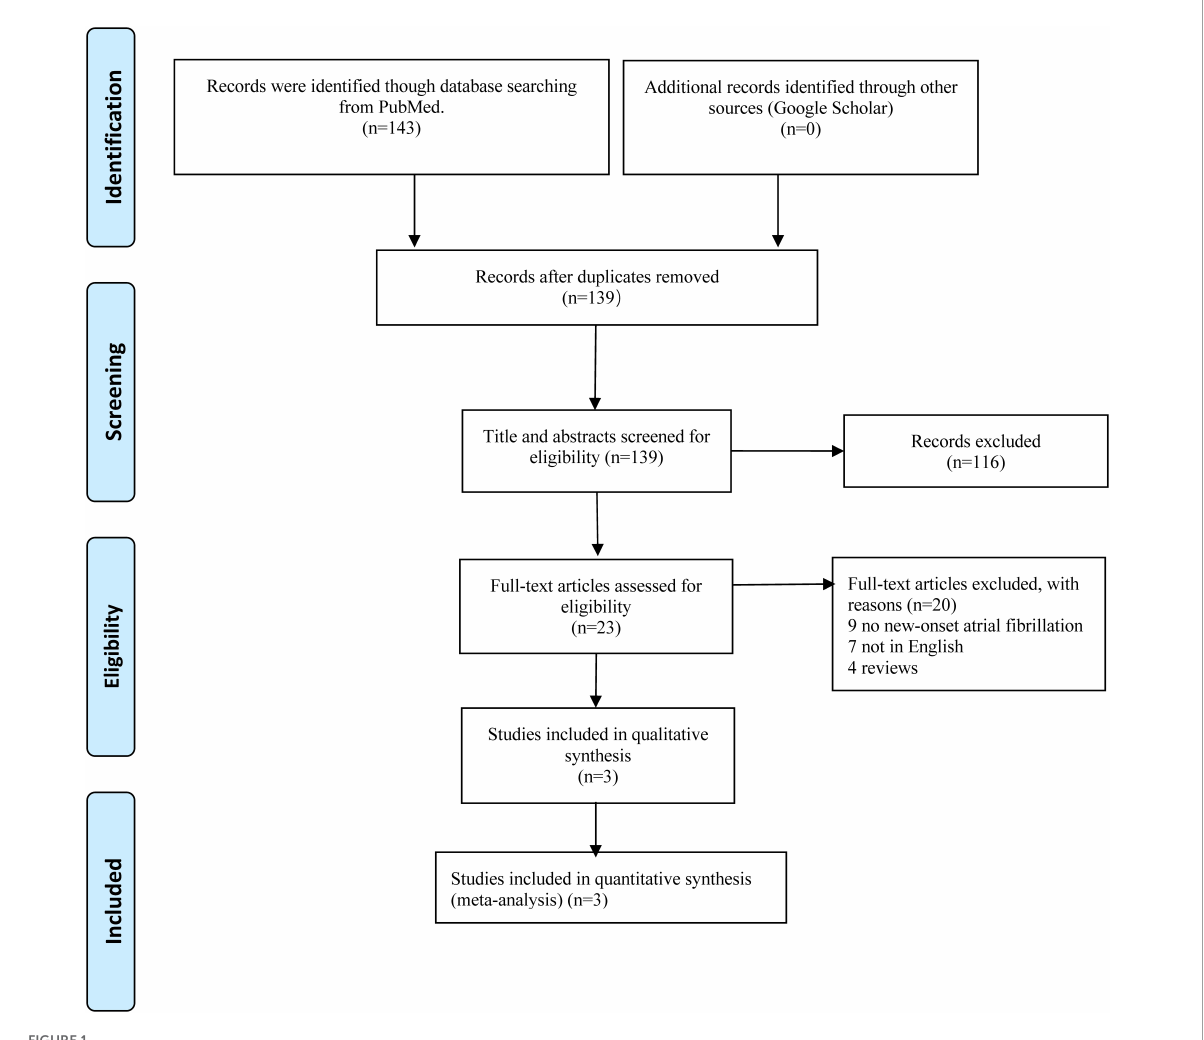
FIGURE1 Diagram of retrieved study selection of this